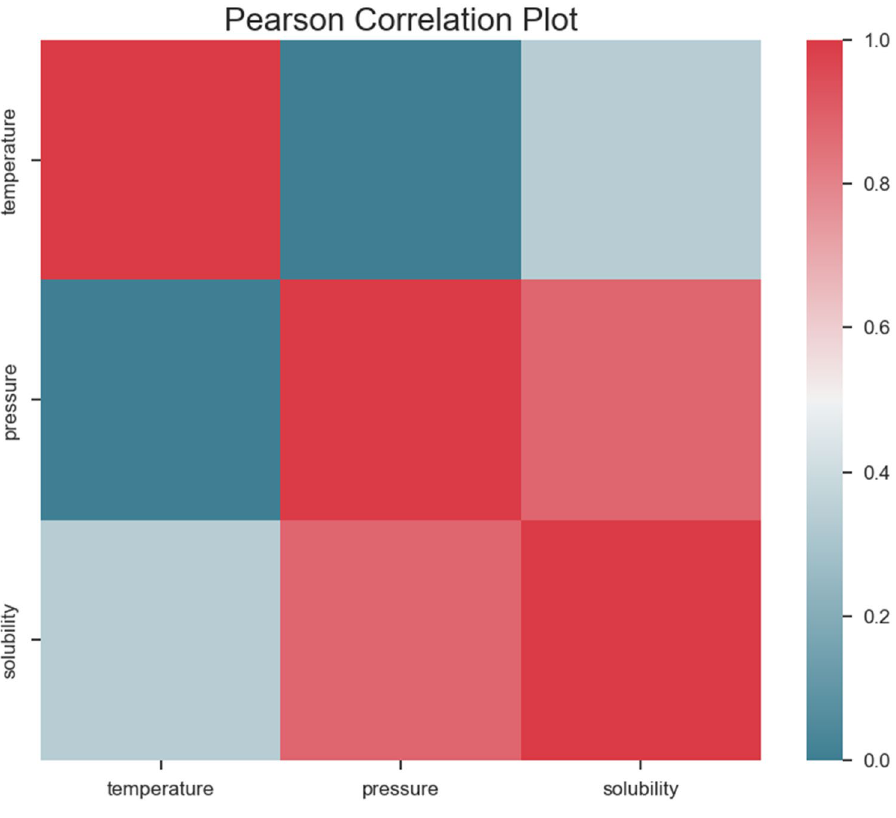
Figure 2. Pearson correlation